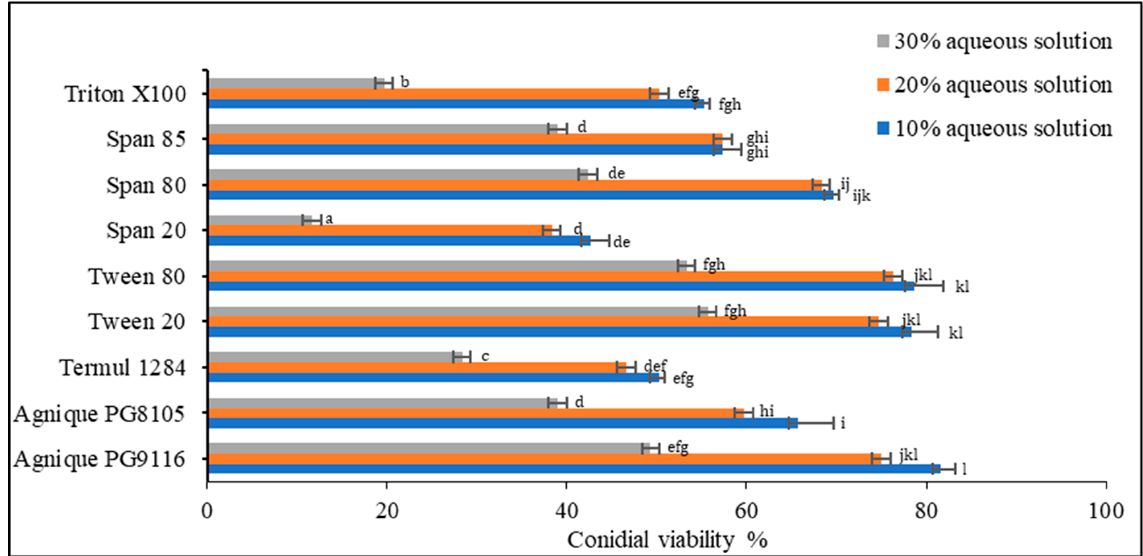
Figure 2. Conidial viability of M. anisopliae (Met-Gra4) conidia with different concentrations of aqueous surfactant solution. Data expressed as mean ± standard deviation ( n = 3). According to Tukey’s HSD test, the means of conidial viability (%) of each surfactant and between tested concentrations followed by different letters indicate significant differences at p = 0.05.